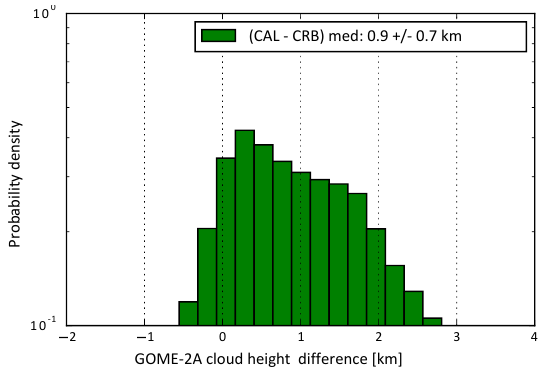
Figure 13. Histogram of the absolute differences between the GOME-2A cloud heights derived from ROCINN_CAL and ROCINN_CRB as seen in Fig.